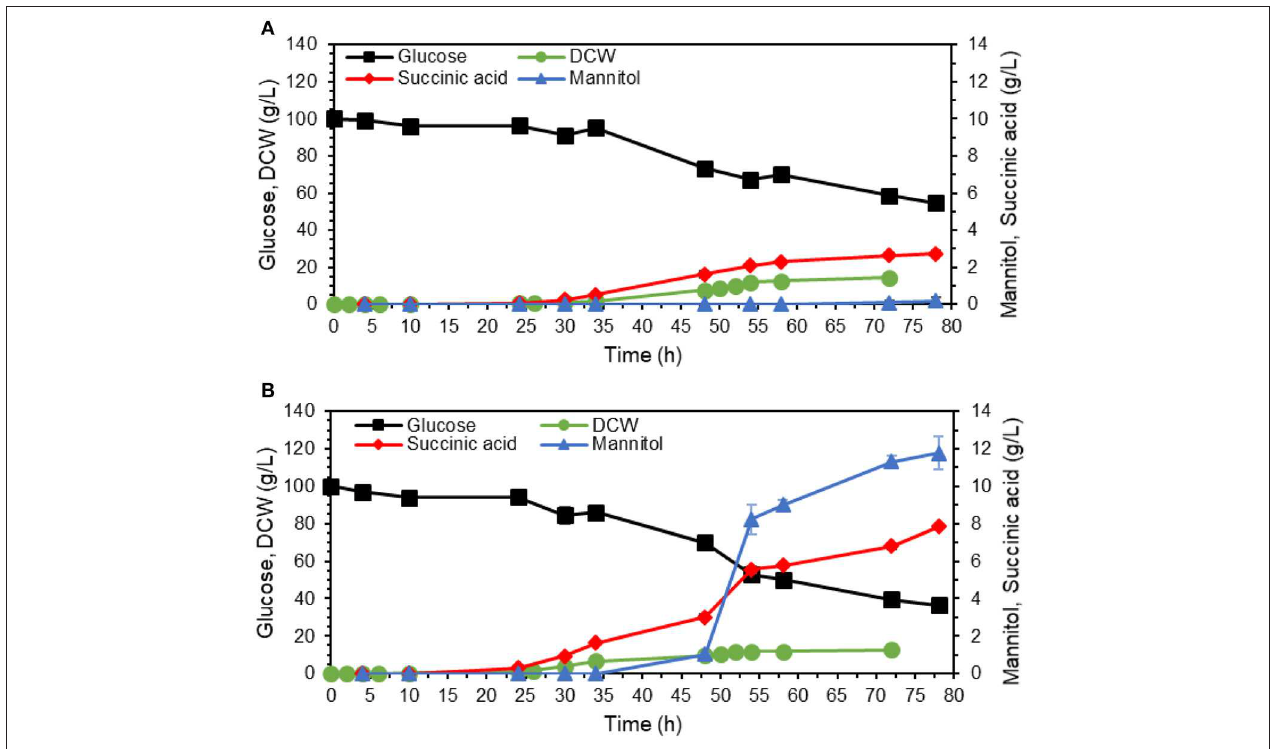
FIGURE 5 | Comparison of the succinate-producing strain ST8578 (A) and its adapted isolate (iso-54) (B) . The strains were cultivated in shake flasks with YP medium containing 100 g/L glucose as carbon source. The values are averages from three biological replicates, the error bars show the standard deviation.